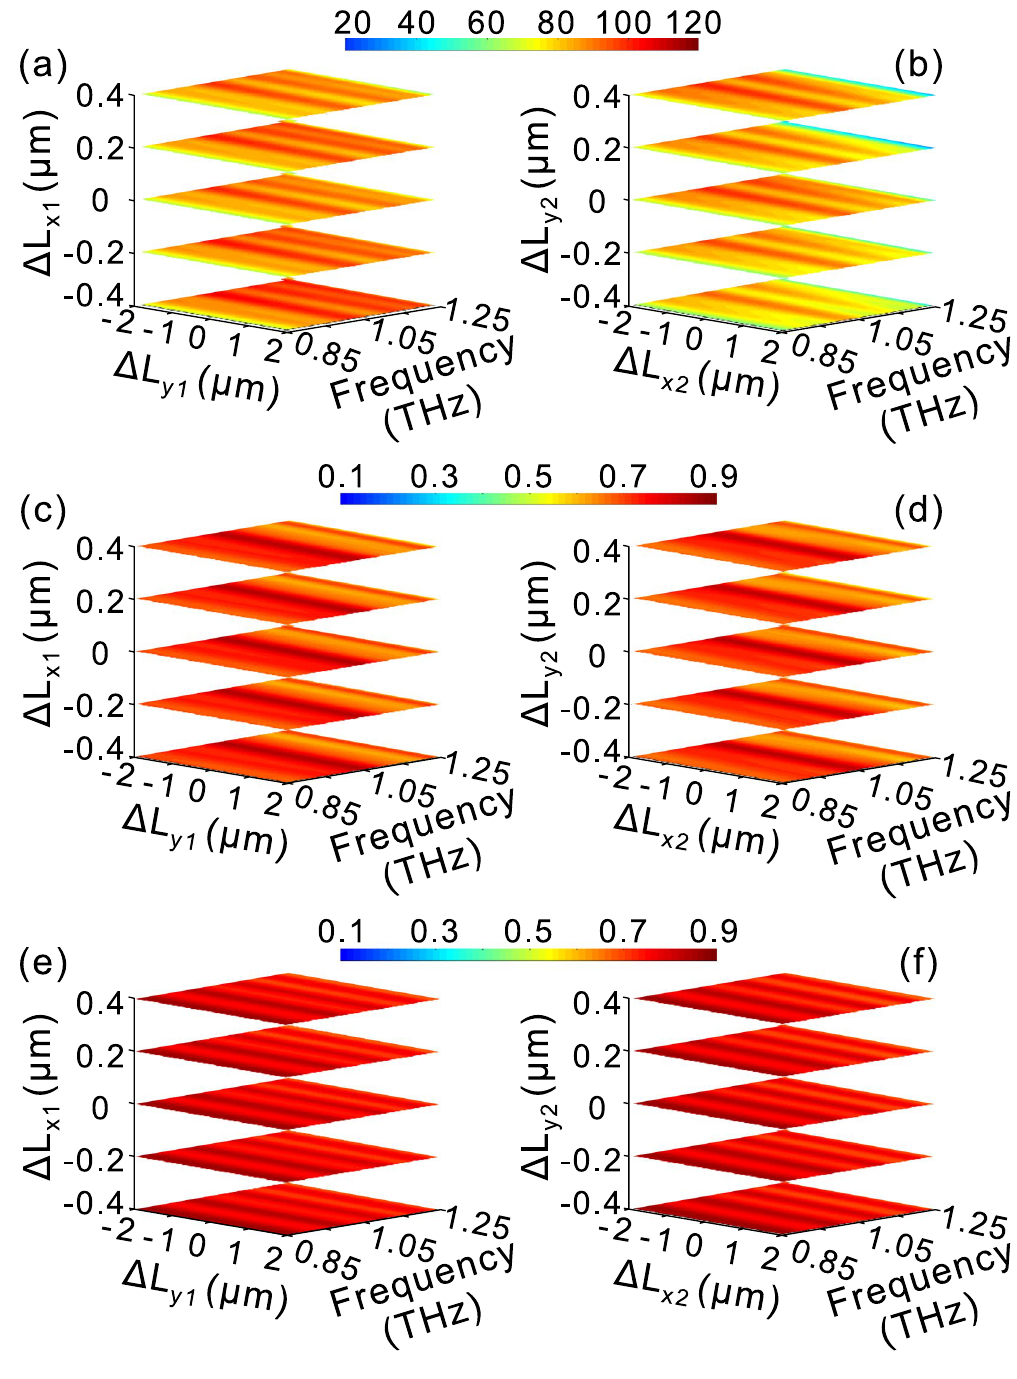
Figure 5. Influence of cross-sectional structural parameters on the performance of the third set of HMM quarter-wave plate in Fig. 4. The phase delay ( a , b ), amplitude of transmission coefficients for different polarizations, t xx ( c , d ) and t yy ( e , f ). In ( a , c , e ), Δ L x1 and Δ L y1 denote the variation with respect to L x1 ( = 62 μ m) and L y1 ( = 20 μ m), respectively, while L x2 , L y2 are fixed at 23 μ m and 47 μ m, respectively. In ( b , d , f ), Δ L x2 and Δ L y2 denote the variation with respect to L x2 ( = 23 μ m) and L y2 ( = 47 μ m), respectively, while L x1 , L y1 are fixed at 62 μ m and 20 μ m,